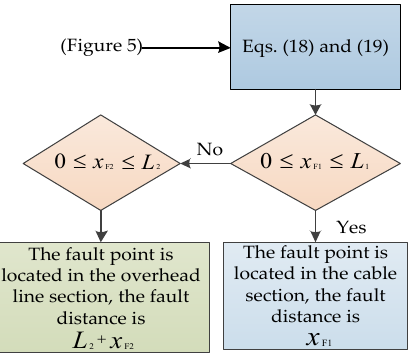
F2 x Figure 3. Fault occurrence at F1 and F2 at the cable and overhead lines. When the fault only occurs at F1 or F2, the fault distance at the cable and overhead lines can be calculated as follows: